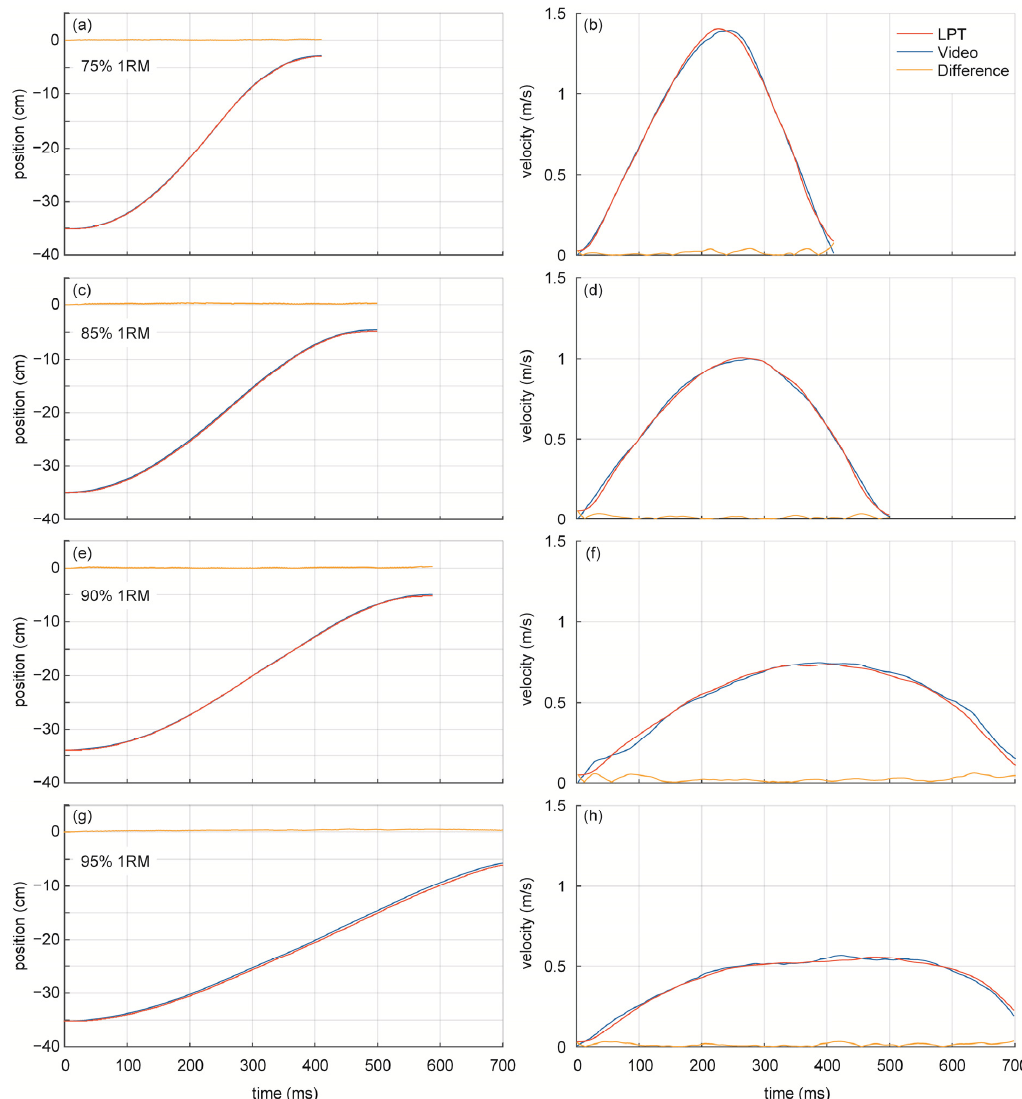
Figure 6. Position–time and velocity–time curves for one repetition of linear position transducer (LPT) system (blue line), video system (red line), and difference between systems (orange line); ( a , b ) 75% 1RM; ( c , d ) 85% 1RM; ( e , f ) 90% 1RM; ( g , h ) 95% 1RM.